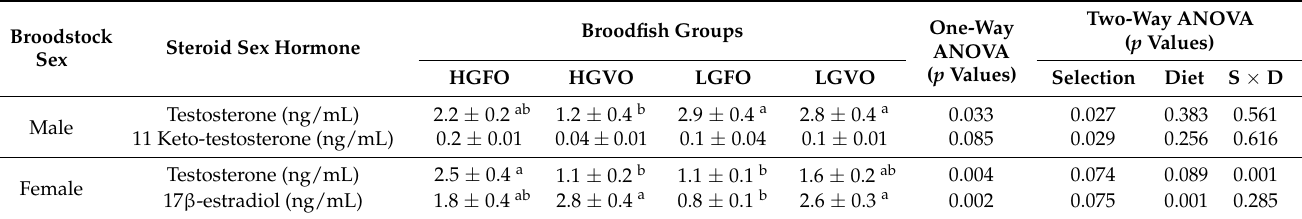
Table 9. Steroid sex hormone levels of gilthead seabream male or female broodstock of high (HG) or low growth (LG) groups fed with either FO or VO diet over three months of reproductive season (HGFO, n = 5; HGVO, n = 5; LGFO, n = 5; LGVO, n = 5).